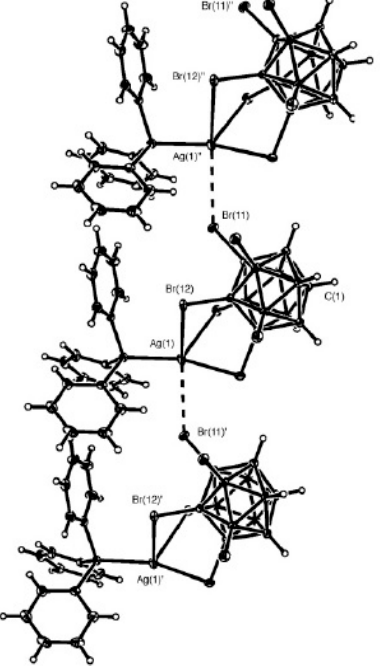
Figure 93. Fragment of X-ray structure of {(Ph 3 P)Ag[HCB 11 H 5 -7,8,9,10,11,12-Br 6 ]}. Reproduced with permission from reference [110]. Copyright © (2002) John Wiley & Sons.